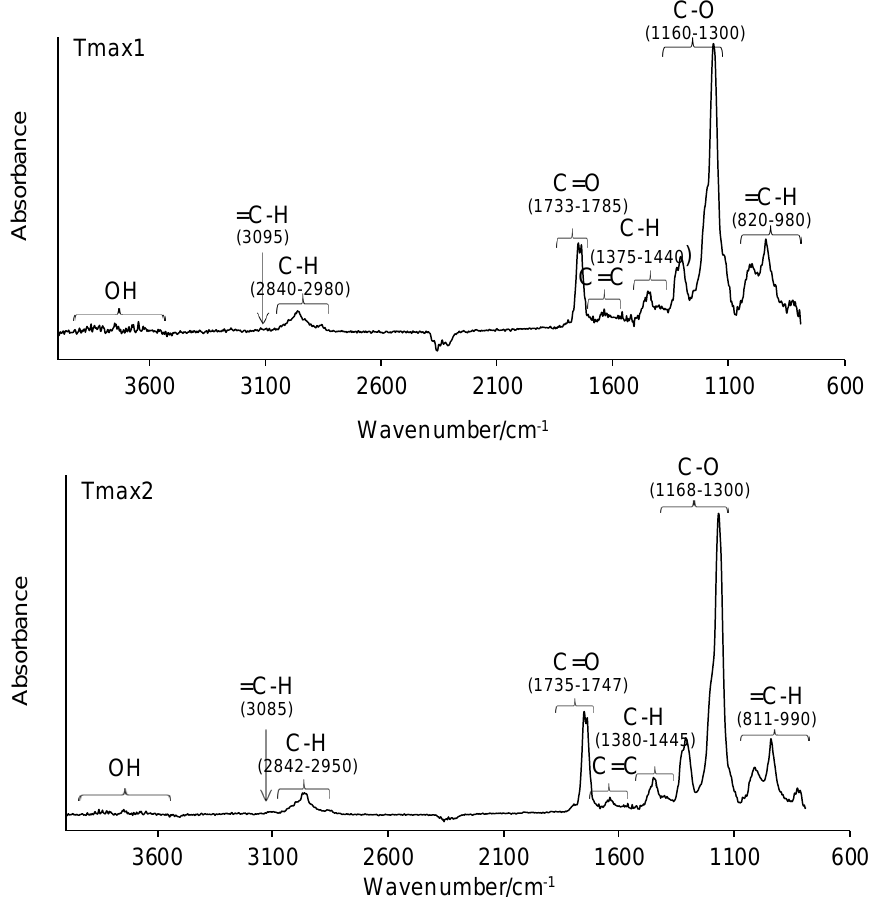
Figure 5. The FTIR spectra of volatiles emitted under the heating of copolymers 1–3 in helium.